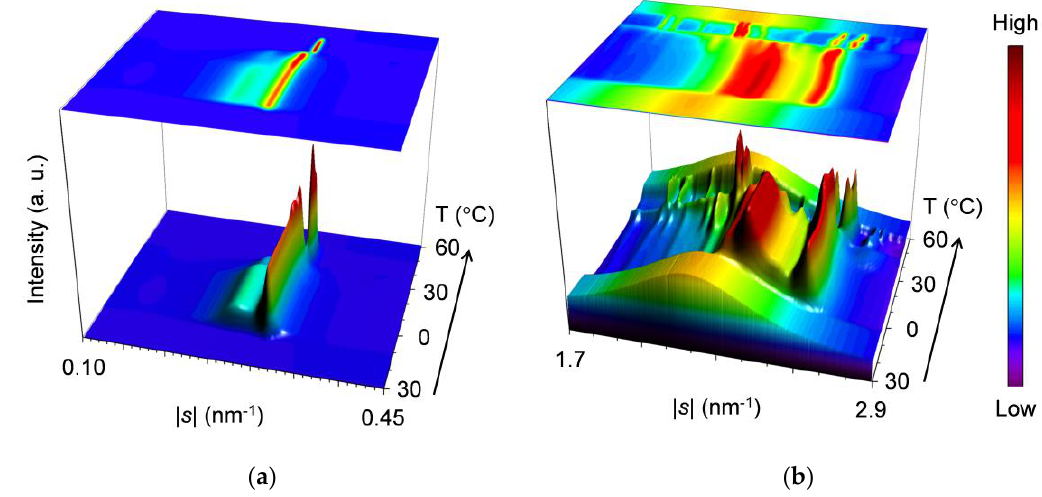
Figure 4. Topographic plots of the SR-XRD data for SOS/LLL ( w LLL = 0.667), taken during the cooling at a rate of 2 °C/min and subsequent heating at a rate of 5 °C/min: ( a ) SAXS; and ( b ) WAXS. During cooling, a single peak at | s | = 0.304 nm −1 ( d = 3.29 nm) occurs first at ~18 °C, indicating